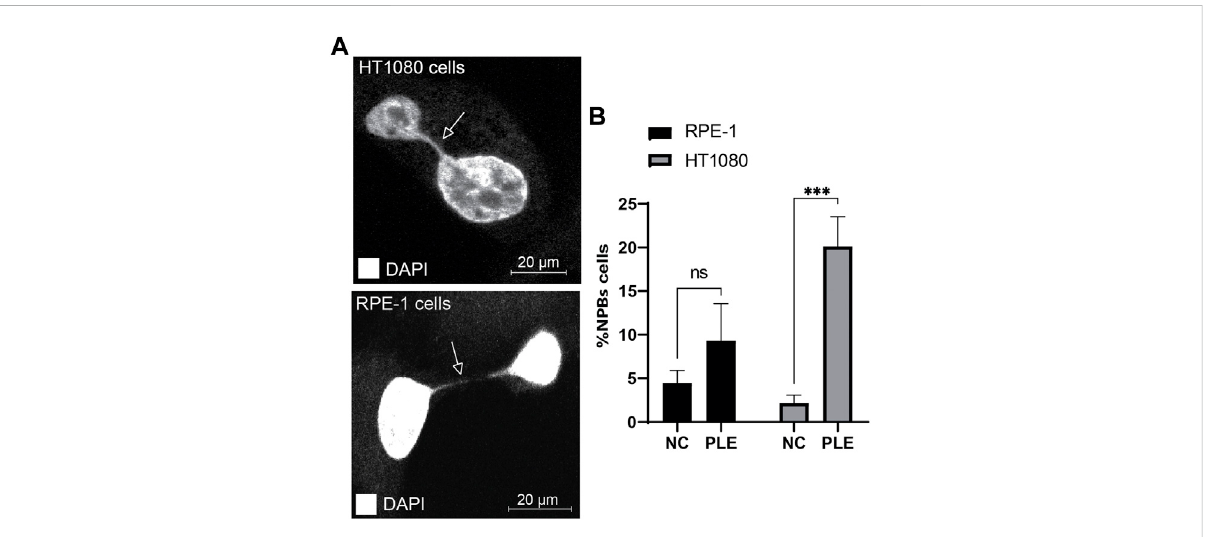
Accumulation of NPBs in HT1080 and RPE-1 cells treated with PLE. (A) Representative pictures of NPBs in HT1080 and RPE-1 cells after PLE treatment. (B) The percentage of NPBs in HT1080 and RPE-1 cells. Error bars correspond to a standard deviation (SD) of four replicates. Statistical analysis was performed using 2way ANNOVA, asterisks indicate statistical signi fi cance (* p < 0.005, *** p < 0.0005, relative to the negative control — untreated